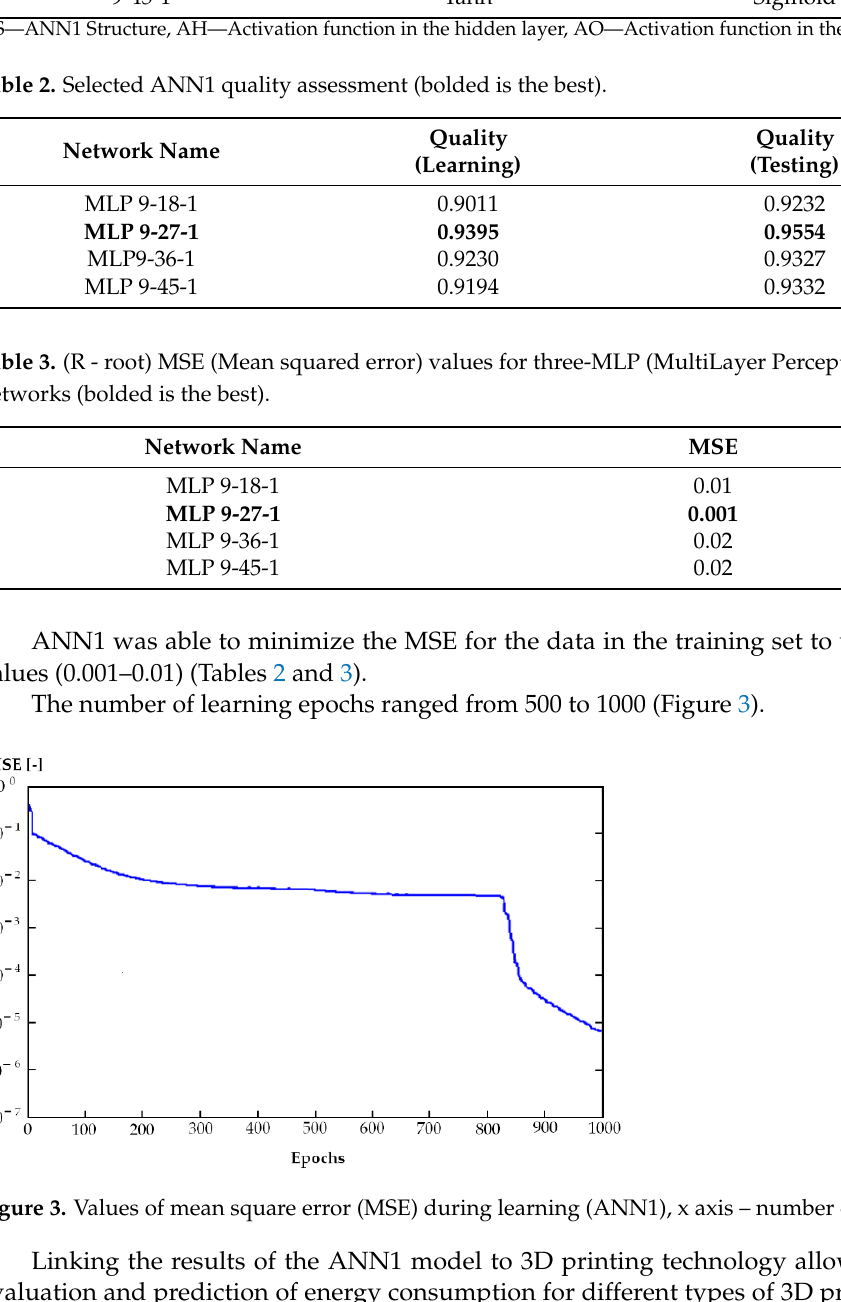
Table 2. Selected ANN1 quality assessment (bolded is the best).